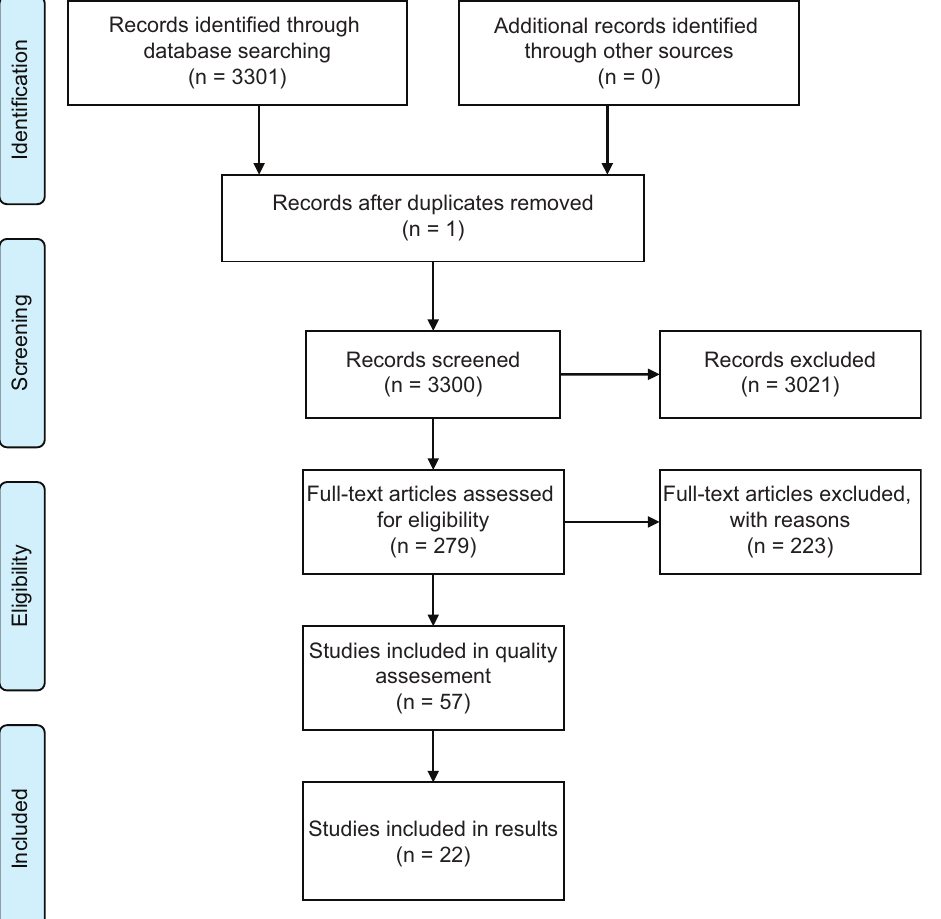
FIGURE 1. Flowchart of a selection of studies for the